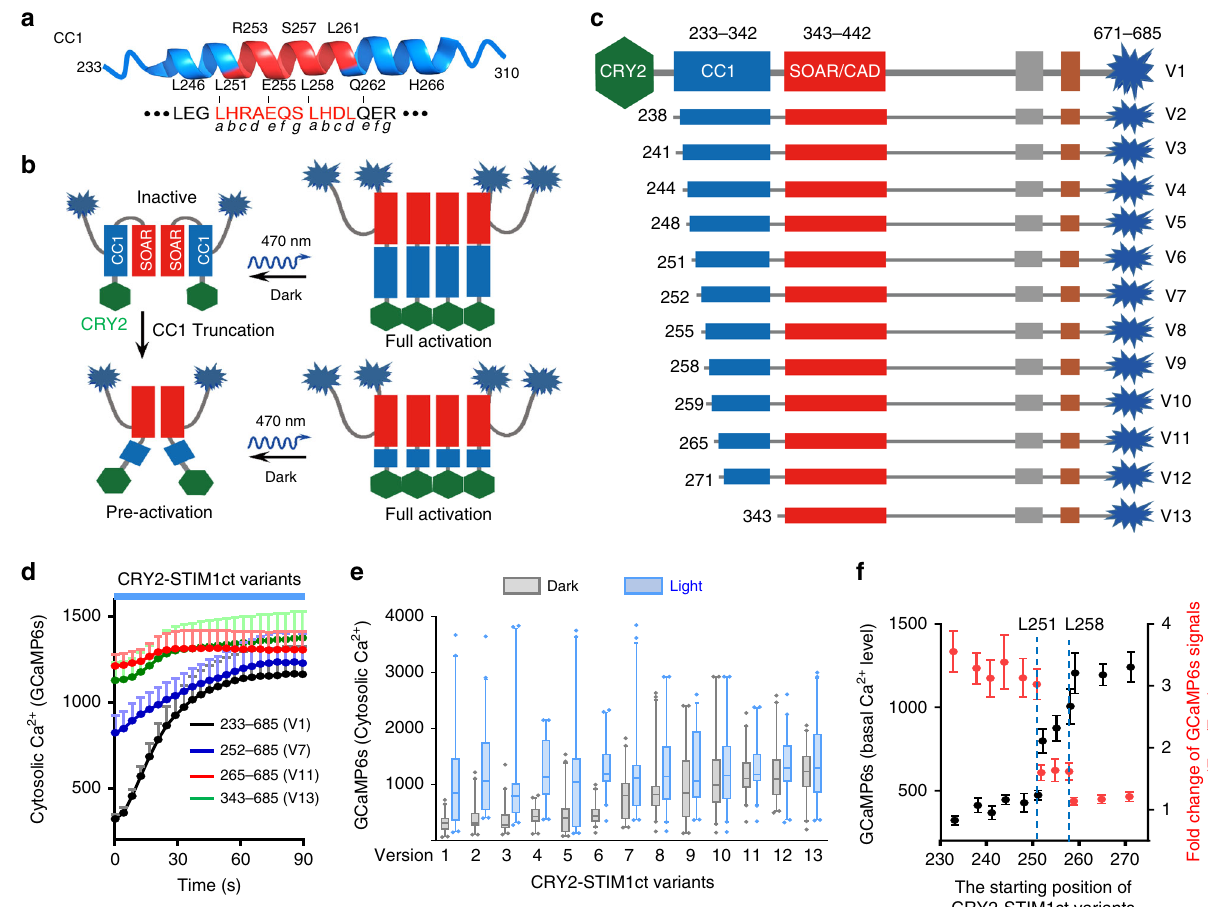
Fig. 3 Optogenetic mapping of the CC1 – SOAR contact interface that mediates STIM1ct autoinhibition. Data were shown as mean ± sem. Scale bar, 5 µ m. a The 3D structure of the juxta-ER membrane region of CC1 (selected residues 241 – 271; PDB entry: 4O9B), with the predicted helical heptad repeats indicated below the cartoon. b , c Summary of the anticipated outcomes in HeLa cells transfected with the full-length or truncated STIM1ct variants. CRY2- fusion constructs were depicted in panel c . d – f Light-triggered Ca 2 + responses for the indicated CRY2-STIM1ct variants. d GCaMP6s was used to report the basal level of Ca 2 + and light-induced changes of Ca 2 + in fl ux in HeLa cells. e Box-whisker plots showing the GCaMP6s signals before (gray) and after photostimulation (blue) for the indicated CRY2-STIM1ct variants. Data were presented as median and the interquartile range with 5 – 95 percentile distribution. f The basal Ca 2 + levels (left Y axis, black dots) and fold-change of Ca 2 + signals (right Y axis, red dots) plotted against the starting residues